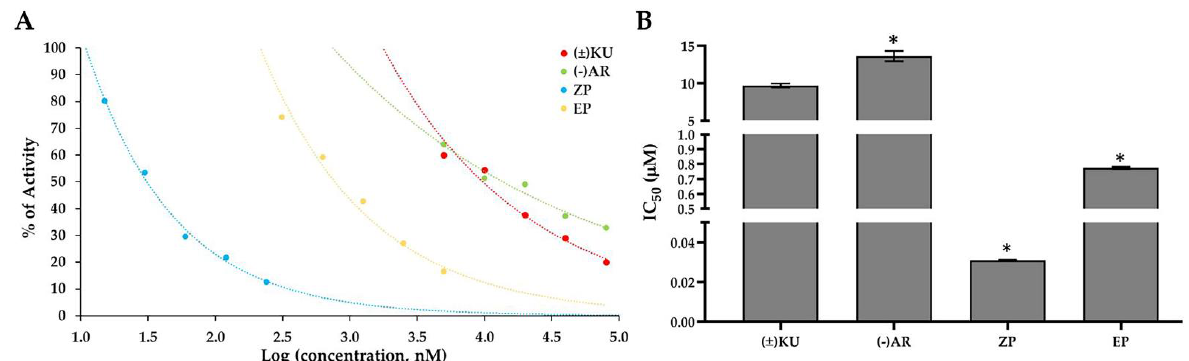
Figure 3 . Inhibitory effect of ( ± ) KU against aldose reductase activity . The mixtures of aldose reduc- Figure 3. Inhibitory effect of ( ± )KU against aldose reductase activity. The mixtures of aldose reductase enzyme, sodium phosphate buffer, NADPH and each tested compound (( ± )KU, ( − )AR, ZP and EP) were incubated at 37 ◦ C for 20 min. Then, substrate (glucose) was added and we immediately monitored the reduction in the absorption of NADPH at 340 nm kinetically for 100 min at 37 ◦ C ( A ). Progress curves of aldose reductase enzyme activity of tested compounds at various concentrations of ( B ) IC 50 values of the tested compounds in the inhibition of aldose reductase activity. Data representation as mean ± SD with two independent experiments. Statistically significant differences in IC 50 values of ( ± )KU vs. ARIs were determined using a one-way analysis of variance followed by Tukey’s multiple comparison test (* p < 0.05). ( ± )KU, trans -( ± )-kusunokinin; ( − )AR, trans -( −